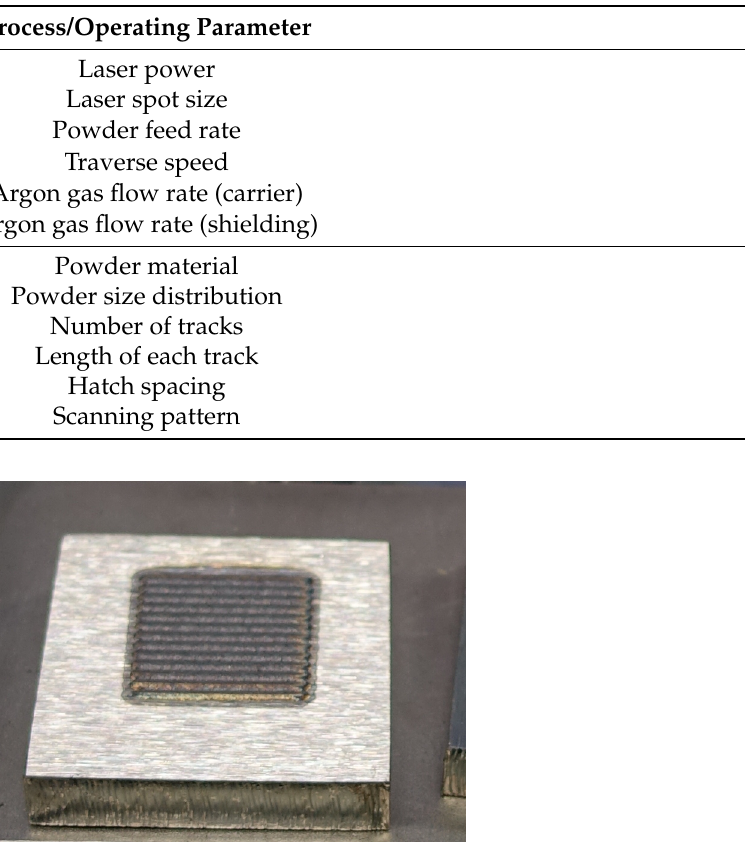
Table 1. Operating conditions.